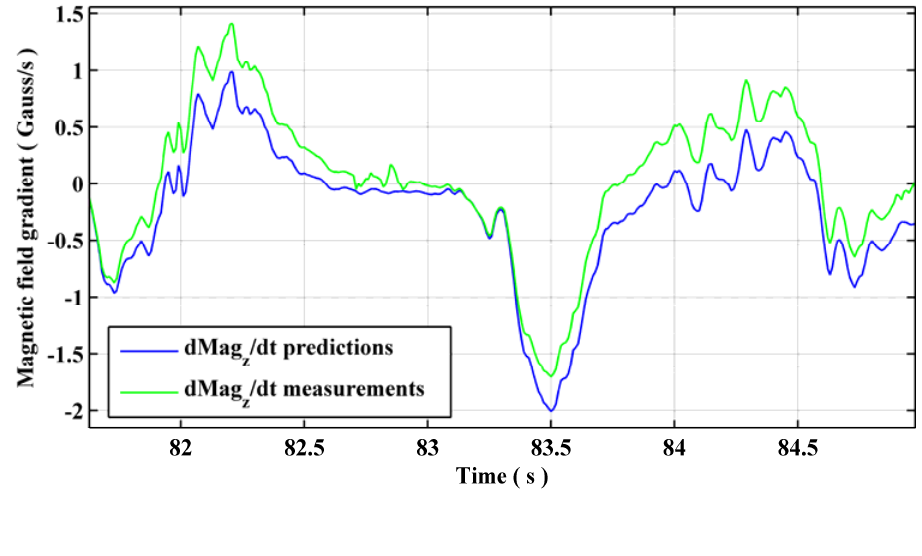
Figure 13. Estimated versus actual rate of change of magnetic field component before gyroscope bias